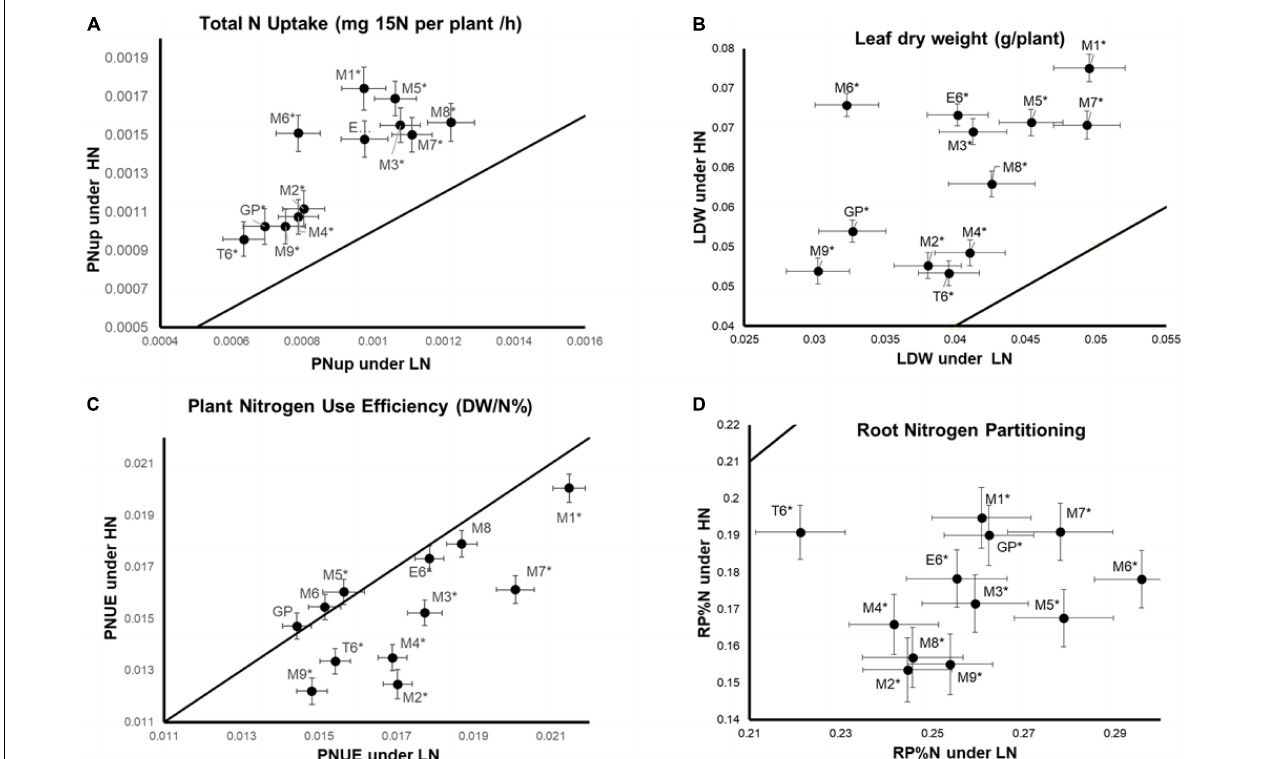
FIGURE 1 | Different genotypes by N supply interactions within the barley North African collection. Plants were grown for 14 days under LN or HN then leaves and roots were harvested separately and frozen under liquid nitrogen. The physiological parameters were measured as indicated in the “Materials and Methods” section. Traits displaying GXN interactions are illustrated by different GXN patterns. (A) Total plant N uptake (PNUpE). (B) Leaf dry weight (LDW). (C) Plant nitrogen use efficiency (PNUE). (D) Root nitrogen partitioning (RP%N). Mean values under HN are plotted against mean values under LN. Four independent experiments were performed. Stars indicate a significant difference between LN and HN (Student’s test, 13 ≤ n ≤ 16, p < 0.05). Bars represent SE.